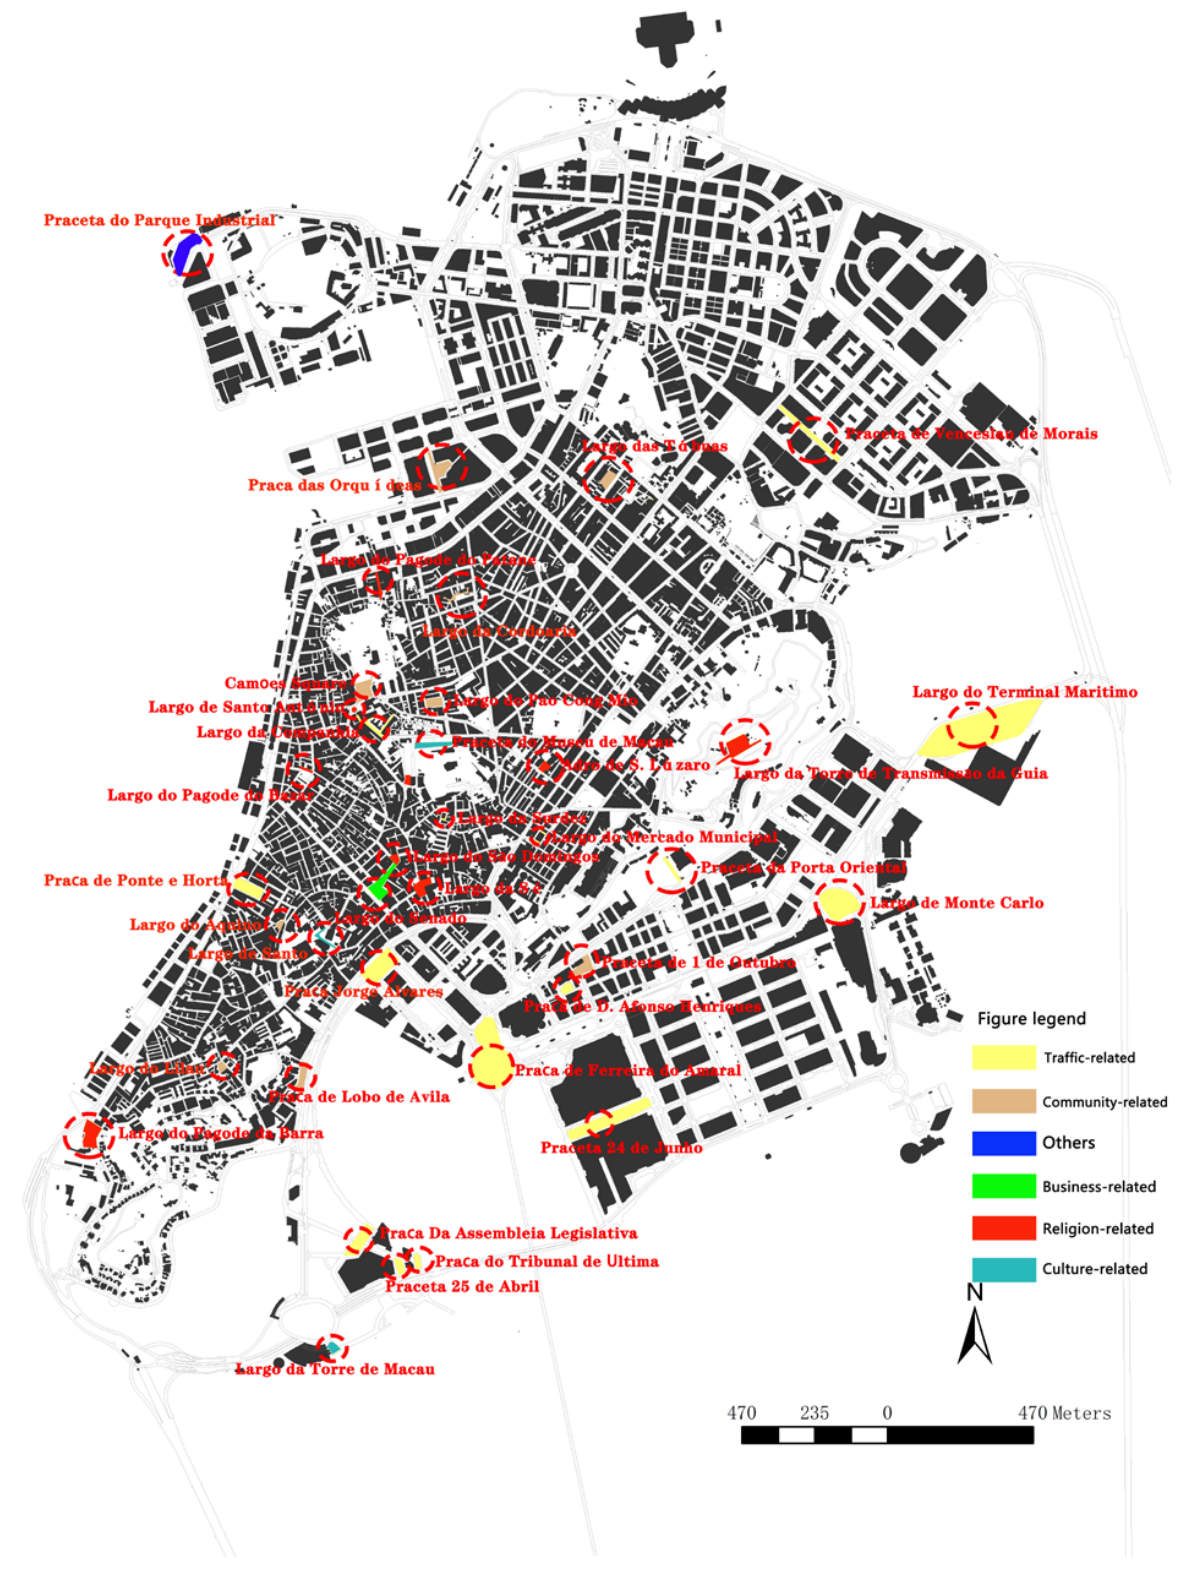
Figure 7. Largos in Macau Peninsula.